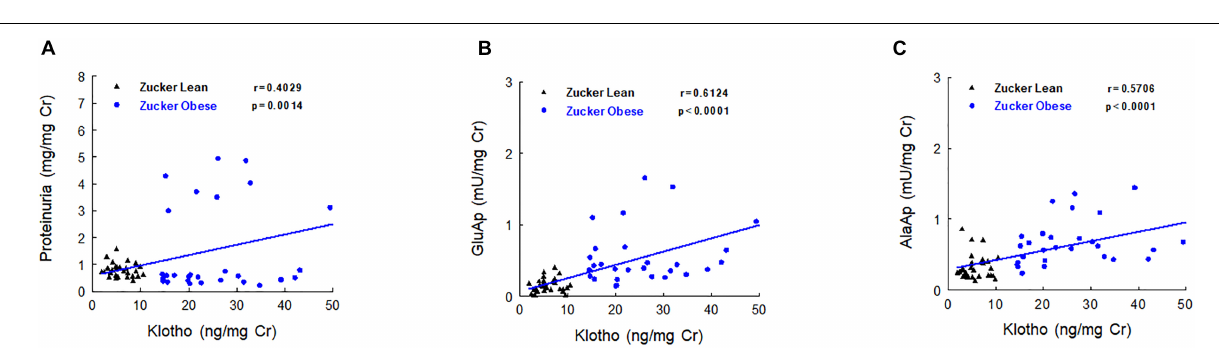
Frontiers in Physiology |